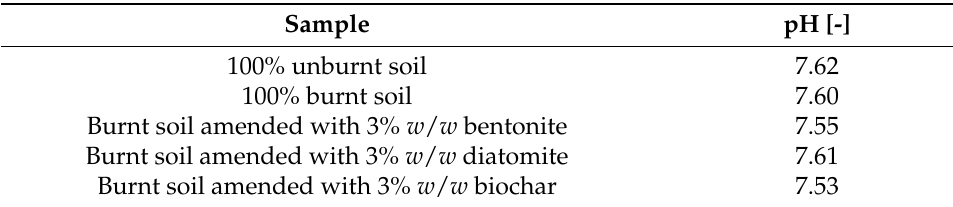
Table 8. pH of amended and unamended samples of burnt soil and unburnt